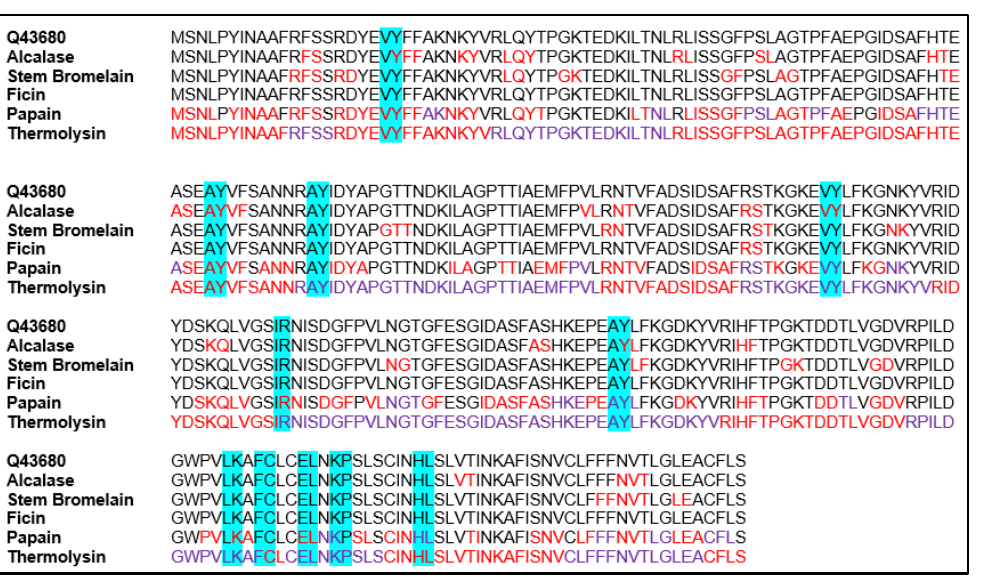
Figure 4. Locations of possible hydrolysis, by proteases selected, within the mung bean albumin sequence Q9FRT8 of the UniProt Database. Amino acids in the sequence are coded using their one letter abbreviation. Hydrolysis is expected to occur between any two adjacent amino acids color-coded the same color (red or purple), but not between amino acids color-coded with different colors or in black text. Each block represents a part of the sequence depicting the different specificities of the proteases stated in the left column. The top block is the start of the sequence. Antioxidant fragments according to the BIOPEP Database in the sequence are highlighted in blue.